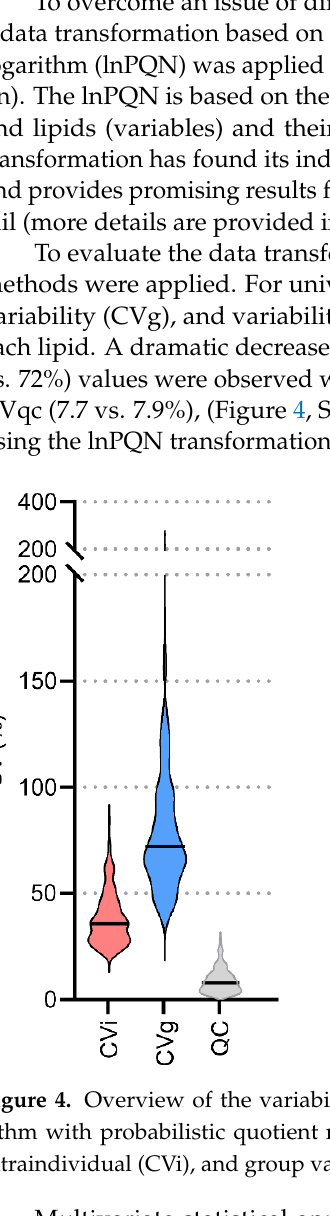
Figure 3. Chromatograms of samples D1R ( A ) and G3L ( B ) with different lipid profiles measured in positive ion mode. Each peak represents a selected MRM transition corresponding to a unique lipid.